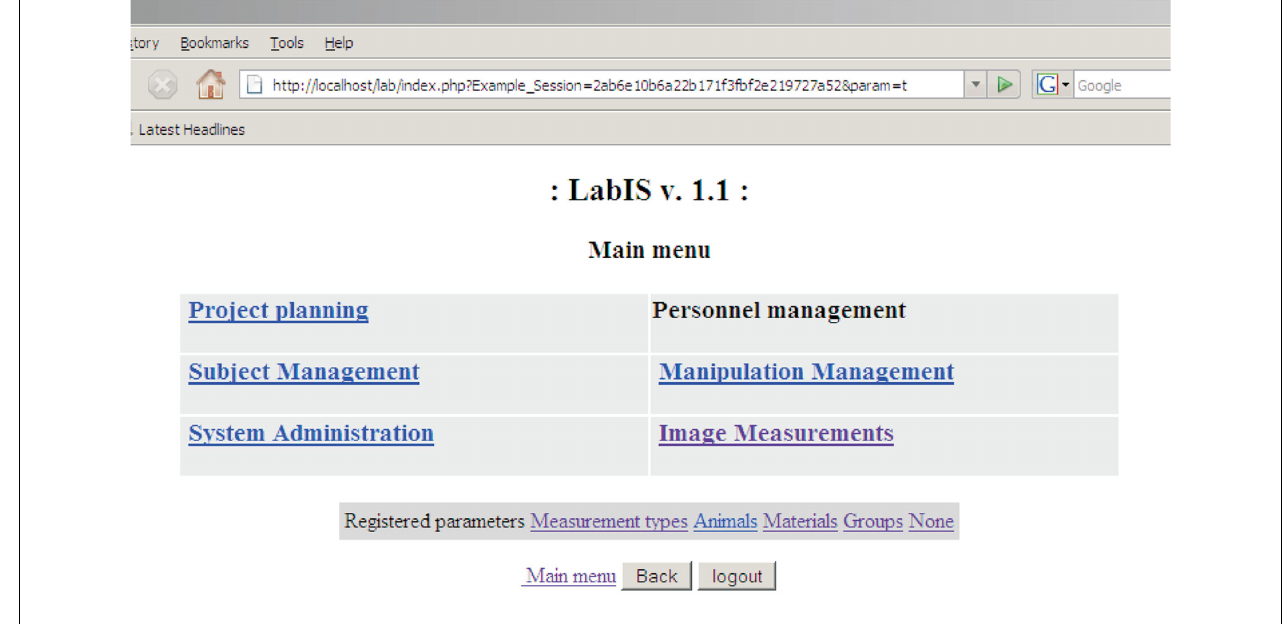
FIGUREA1 |The main menu of LabIS .